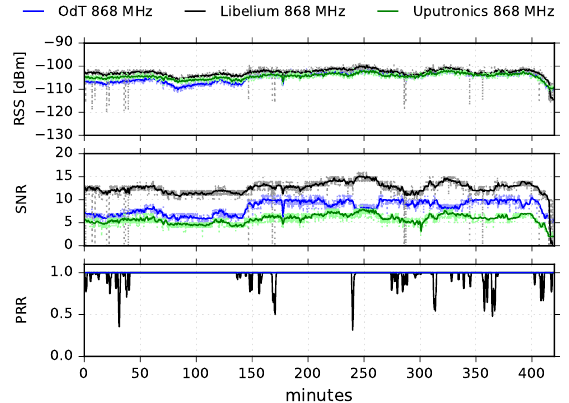
Figure 13. RSS, SNR, and PRR for ODT, Libelium, and Uputronics at 868MHz in LOS channel conditions for BW = 125kHz, SF = 12, and CR = 4/6.